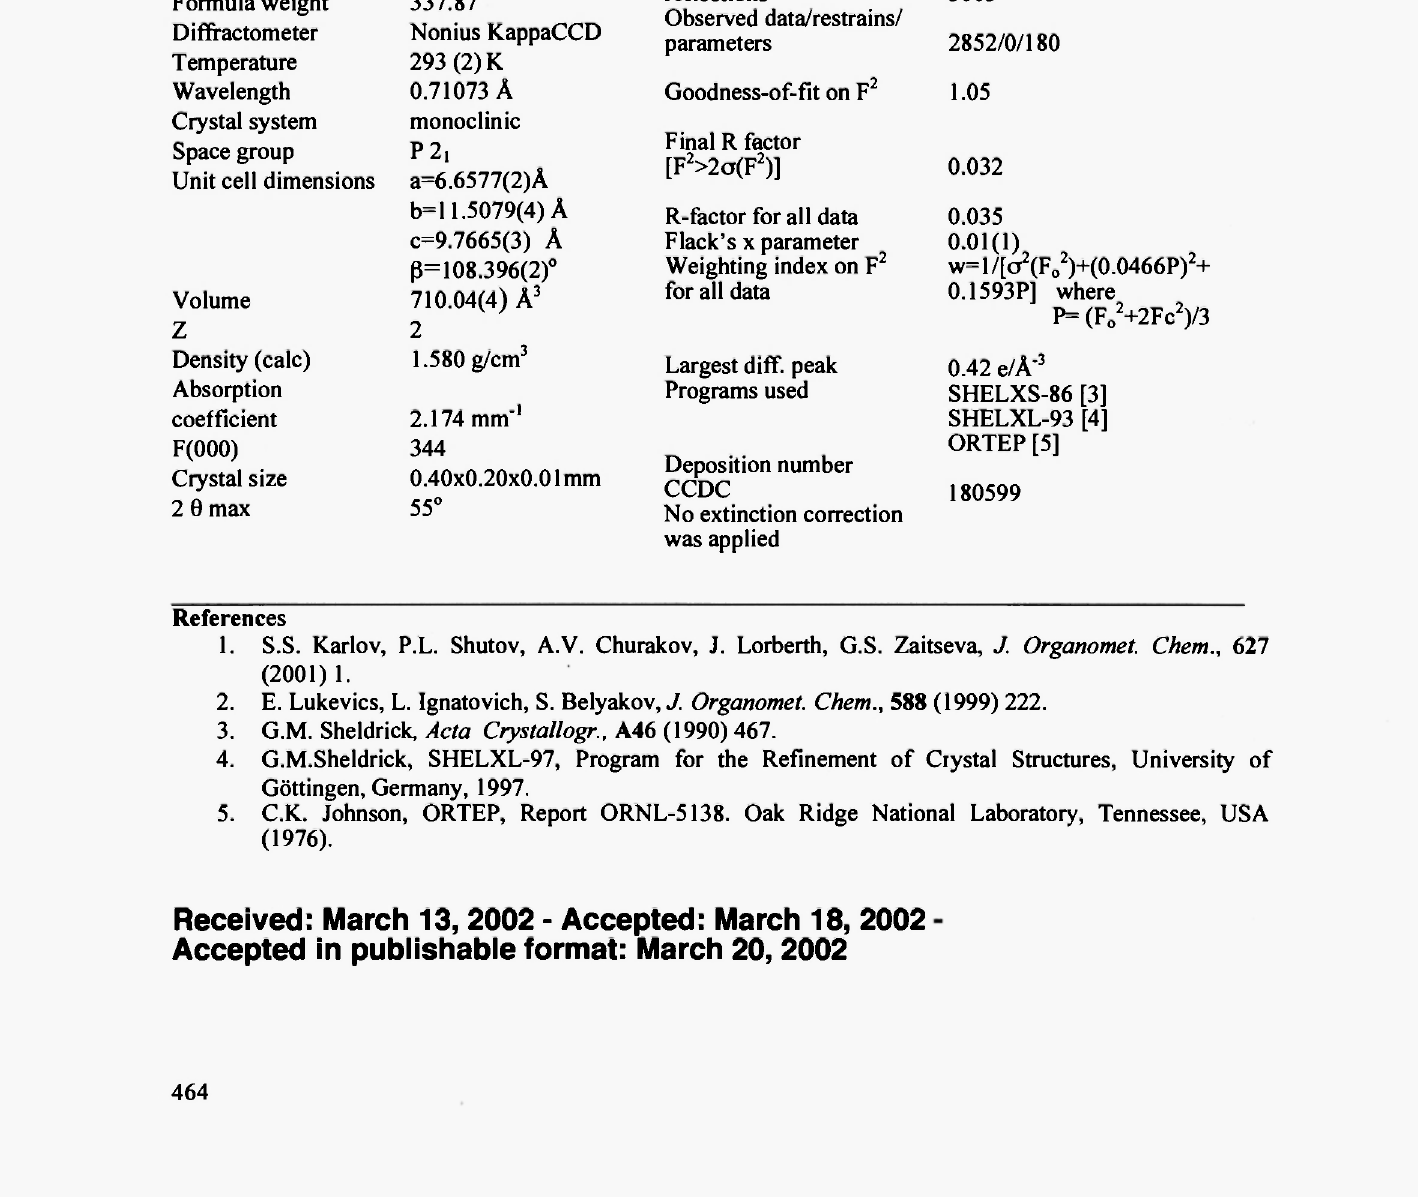
Table 1. Crystal data and structure refinement for